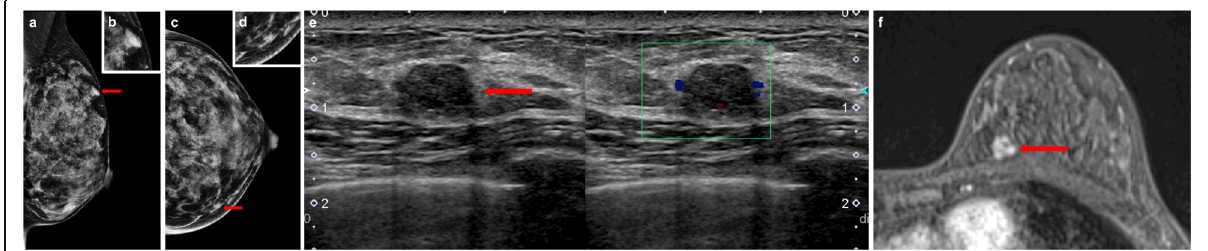
Fig. 1 Imaging findings. Mammogram showing a round, high-density mass in the left MLO-M area ( a ) and CC-I area ( c ). b , d Enlargements of the areas are indicated by red arrows. US shows a regular, circumscribed, hypoechoic, homogenous lesion with abundant blood flow in the A area of the left breast ( e ). Dynamic MRI demonstrates an ill-demarcated mass that measures 8 mm × 7 mm in the A area of the left breast ( f ) without daughter lesions or enlarged lymph